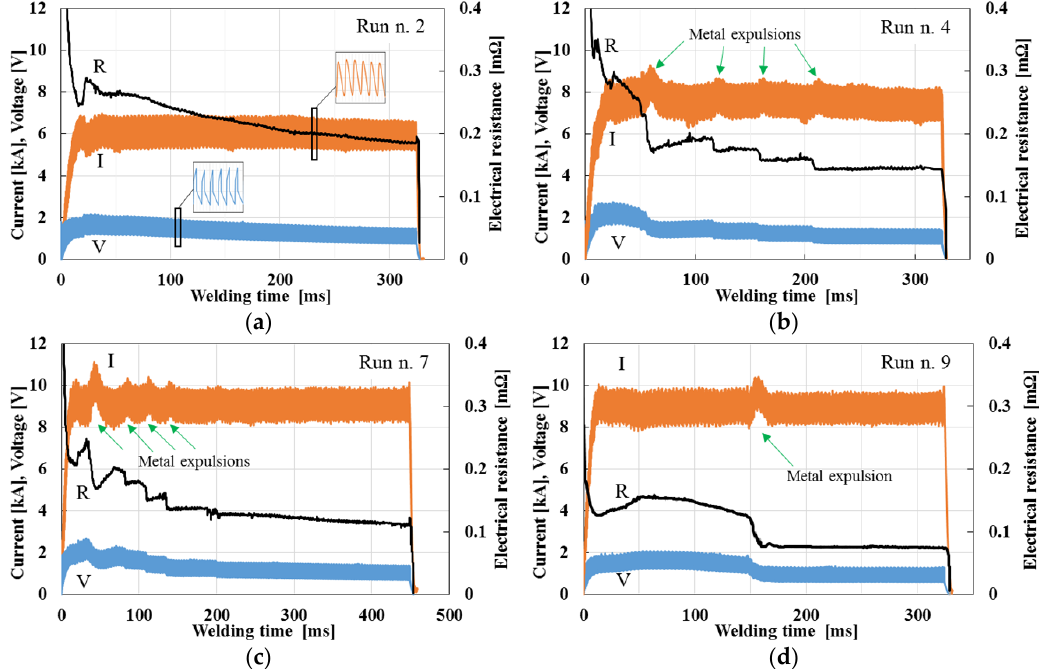
Figure 7. Typical results of the monitoring of the welding current and electrode tip voltage, as well as of the calculated electrical resistance: ( a ) run No. 2 without metal expulsion; ( b ) run No. 4; ( c ) No. 7; and ( d ) No. 9 with metal expulsion. I: welding current; R: electrical resistance; V: electrode tip voltage.